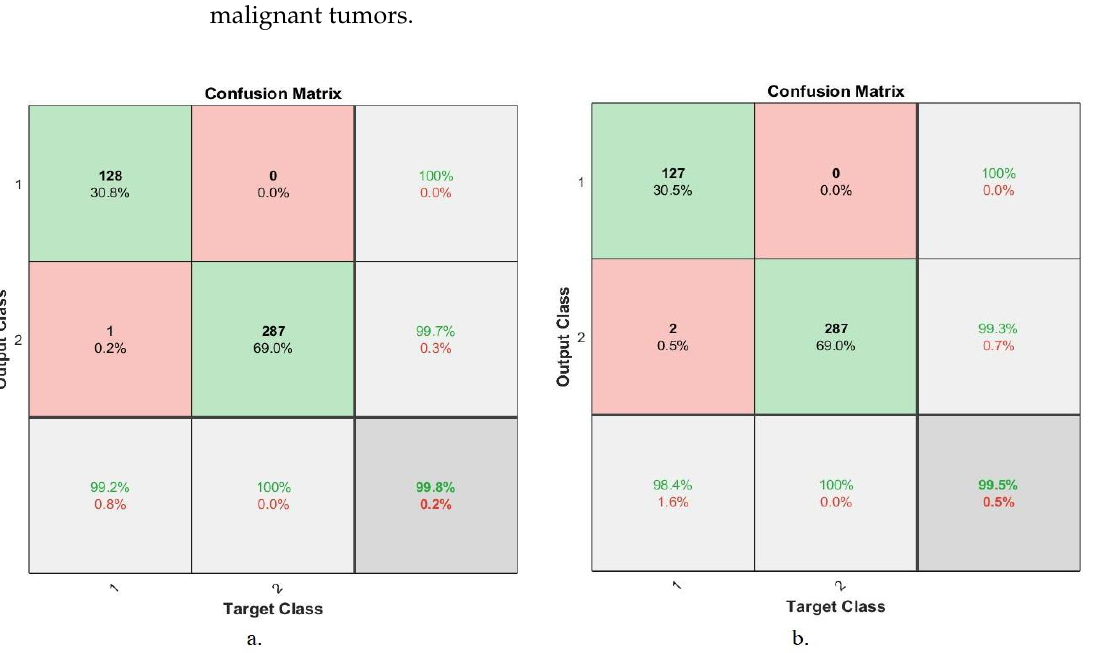
Figure 12. Confusion matrix for ANN for classifying a 100× dataset based on fusion features by ( a ) AlexNet with FCH, LBP, and GLCM and by ( b ) GoogLeNet with FCH, LBP, and GLCM.